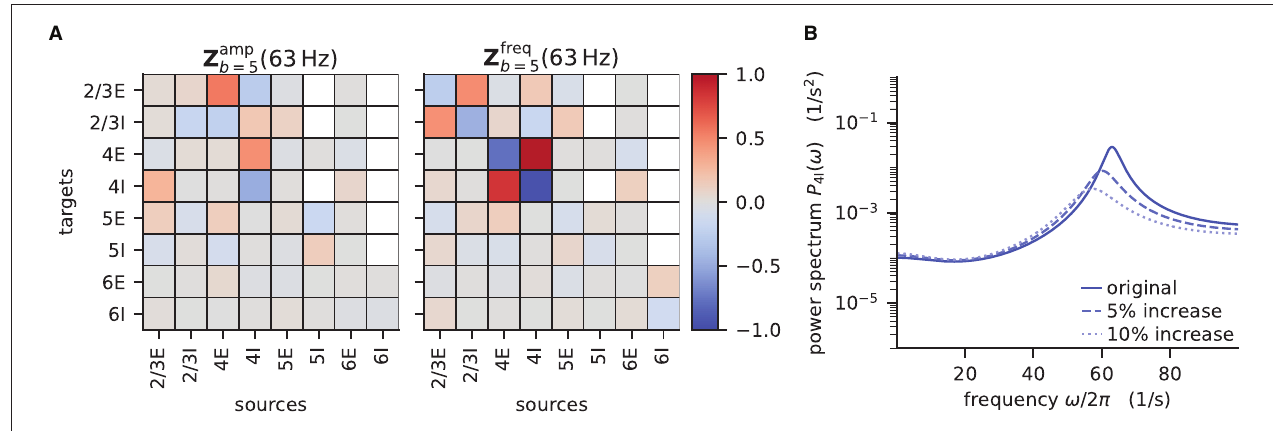
FIGURE 6 | Sensitivity measure at low- γ frequency and corresponding power spectrum of microcircuit with adjusted connectivity. (A) Sensitivity measure of one eigenmode of the effective connectivity relevant for low- γ oscillations. The sensitivity measure for this mode is evaluated at the frequency where the corresponding eigenvalue is closest to the point of instability 1 0i in complex plane. Z amp b ( ω ) (left subpanel) visualizes the influence of a perturbation of a connection on the peak + amplitude of the power spectrum. Z freq b ( ω ) (right subpanel) shows the impact on the peak frequency. Non-existent connections are masked white. (B) Mean-field prediction of power spectrum of population 4I with original connectivity parameters (solid line), 5% increase (dashed line) and 10% increase (dotted line) in